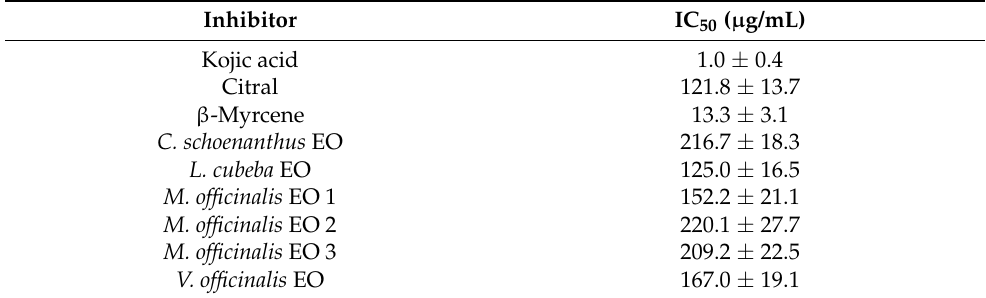
Figure 2. Percentage of tyrosinase inhibition for each investigated EO tested at a concentration of 166.7 µg/mL. Legend: Cs: Cymbopogon schoenanthus (batch 2020); Lc: Litsea cubeba (batch 2020); Mo,1: Melissa officinalis 1; Mo,2: Melissa officinalis 2; Mo,3: Melissa officinalis 3; Vo: Verbena officinalis (bacth 2020). Table 5. IC 50 values of each investigated essential oil and of some bioactive components together with their relative standard deviation value.